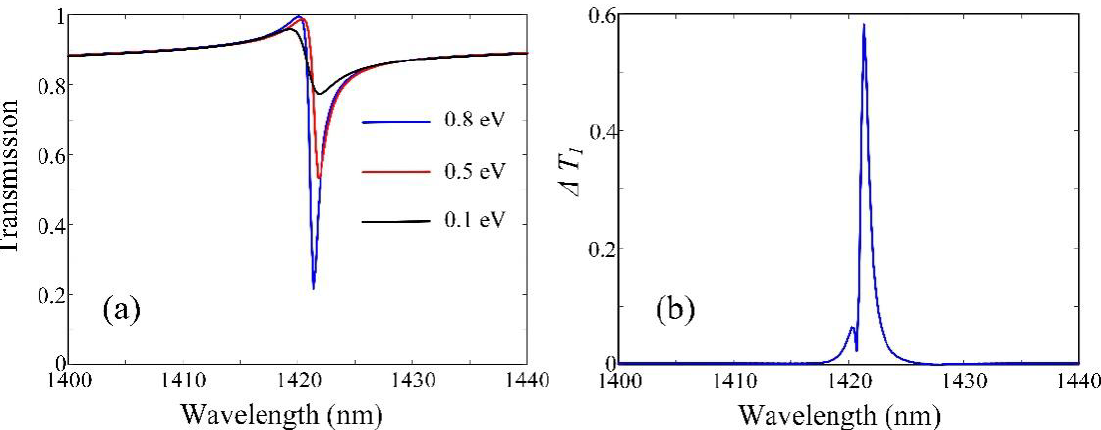
Figure 5. ( a ) Transmission spectra of the proposed modulator with different Fermi energies of the monolayer graphene when α = 75. ( b ) The absolute value of the transmission difference between the cases of E F = 0.8 eV and E F = 0.1 eV when α = 75.